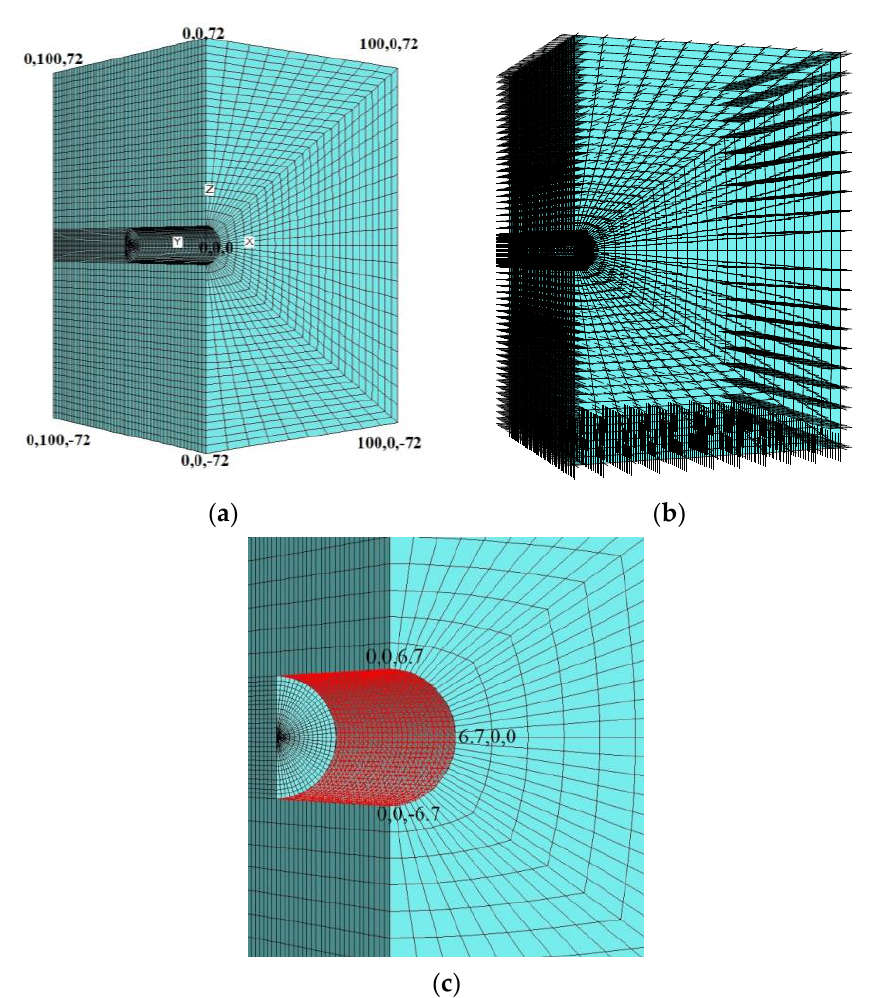
Figure 8. ( a ) FLAC3D model; ( b ) FLAC3D model boundary conditions; ( c ) FLAC3D model tunnel section and shell element.